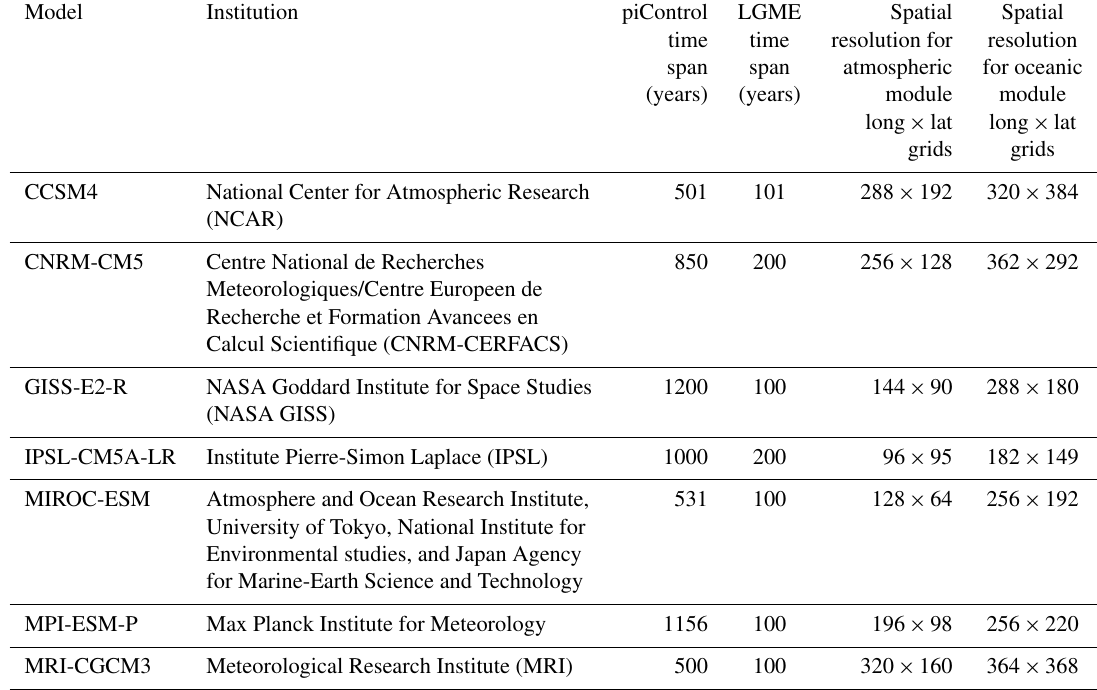
Table 1. CMIP5–PMIP3 models and experiments used in this study.